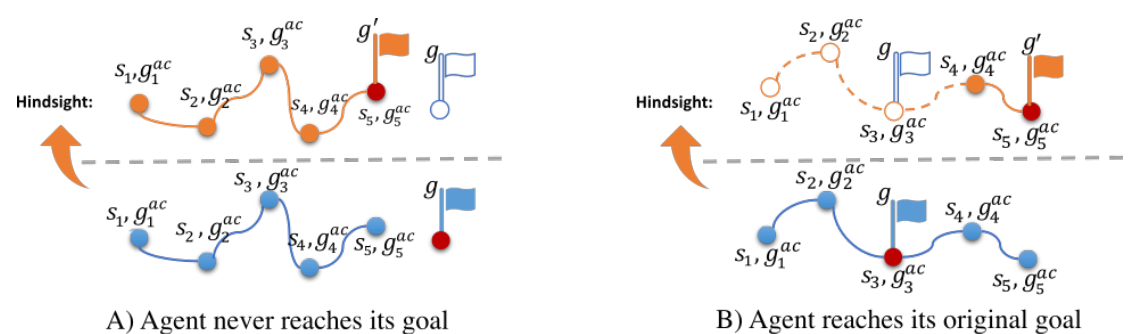
Figure 2. A simplified illustration of trajectory selection. Blue trajectories indicate original experiences. Orange trajectories indicate hindsight experiences. Solid trajectories in the hindsight experiences are selected by the trajectory selection module of ESIL with new “imagined” goals.